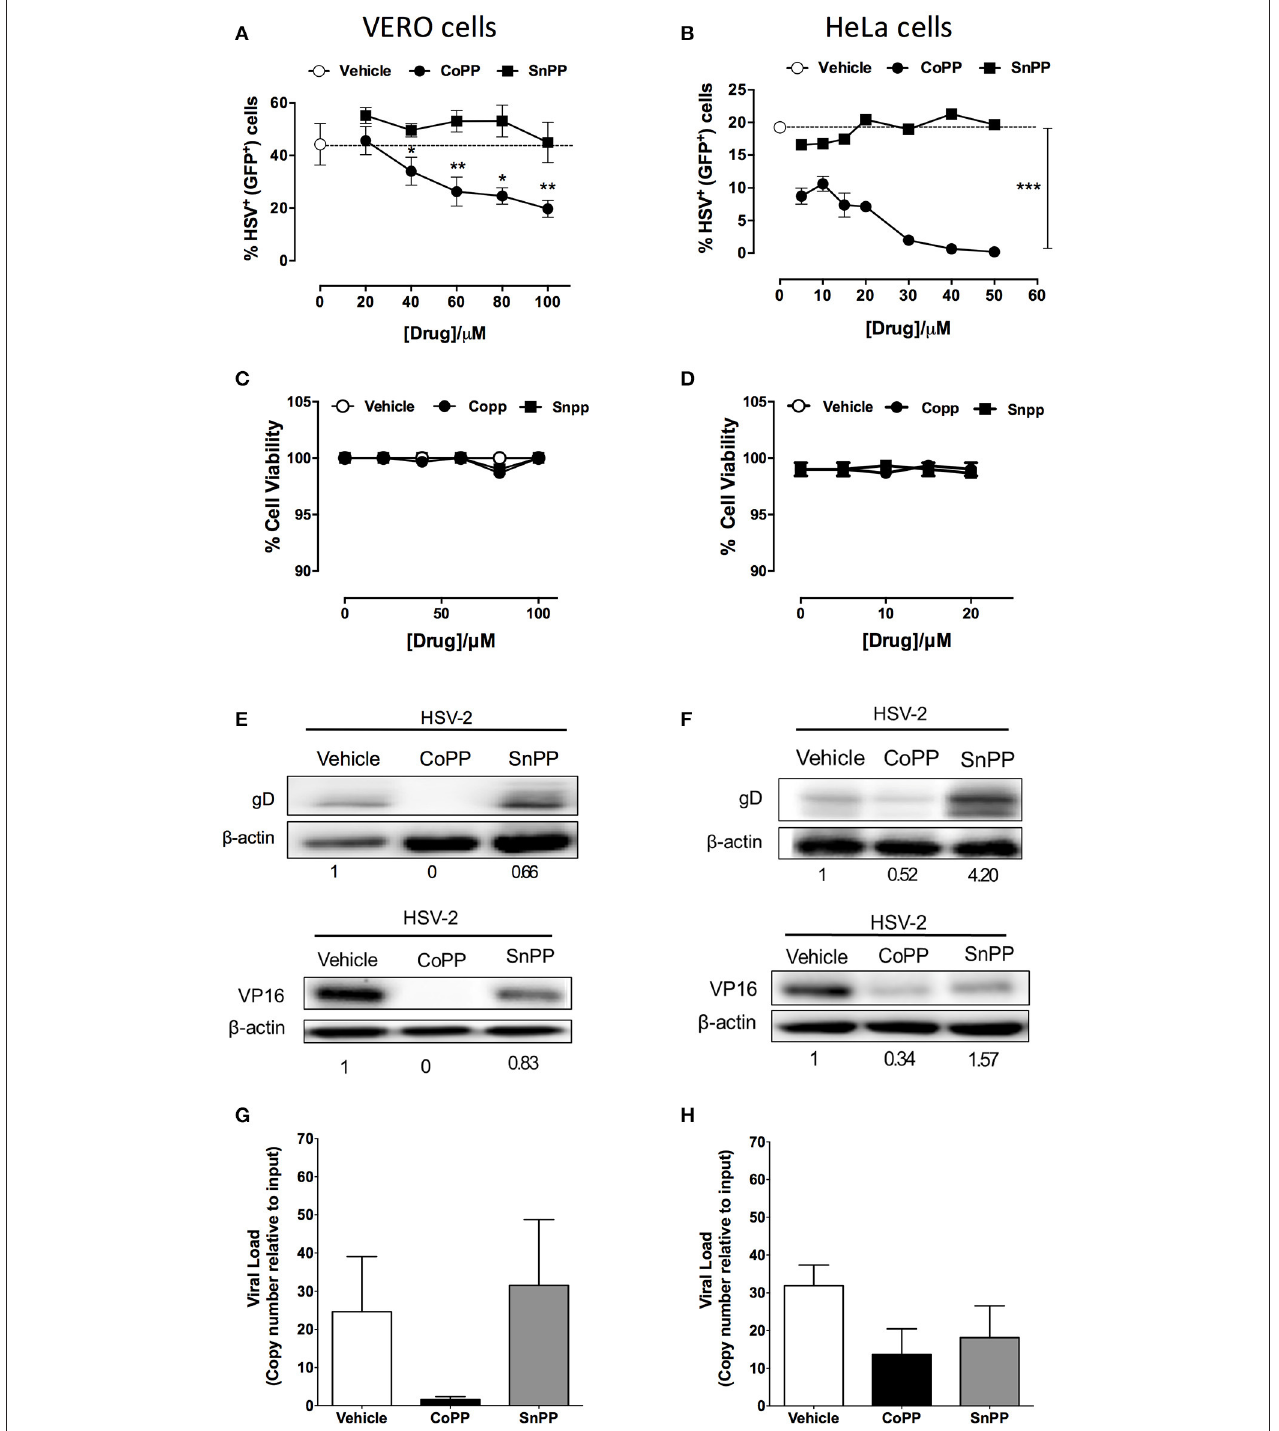
FIGURE 2 | Pharmacological induction of HO-1 restricts the expression of HSV-encoded genes in epithelial cells. (A,B) Flow cytometry analyses of GFP-derived fluorescence in Vero (left) and HeLa cells (right), respectively infected at MOI 1 with HSV-2 that encodes a non-structural GFP reporter gene under the control of a constitutive promotor, in response to varying concentrations of HO-1-modulating drugs. (C,D) Cell viability was assessed for Vero (left) and HeLa cells (right) for treatment with varying concentrations of HO-1-modulating drugs. (E,F) Western blot analyses for viral proteins gD and VP16 in Vero (left) and HeLa (right) cells at 16h post-infection with HSV-2 at an MOI 1 after treatment with 60 and 10 µ M, respectively of HO-1-modulating drugs. (G,H) Quantification of viral genome copies in Vero (left) and HeLa cells (right) by qPCR at 18h post-infection at MOI 10. Data are means ± SEM of three independent experiments for experiments (A–F) and two independent experiments for (G,H) . Representative images are shown for Western blots. Two-way ANOVA, and Tukey’s multiple comparison test were used for statistical analyses (A) : statistics is shown for the CoPP treated group vs. SnPP-treated and untreated (* p < 0.05, ** p < 0.01, *** p < 0.001).